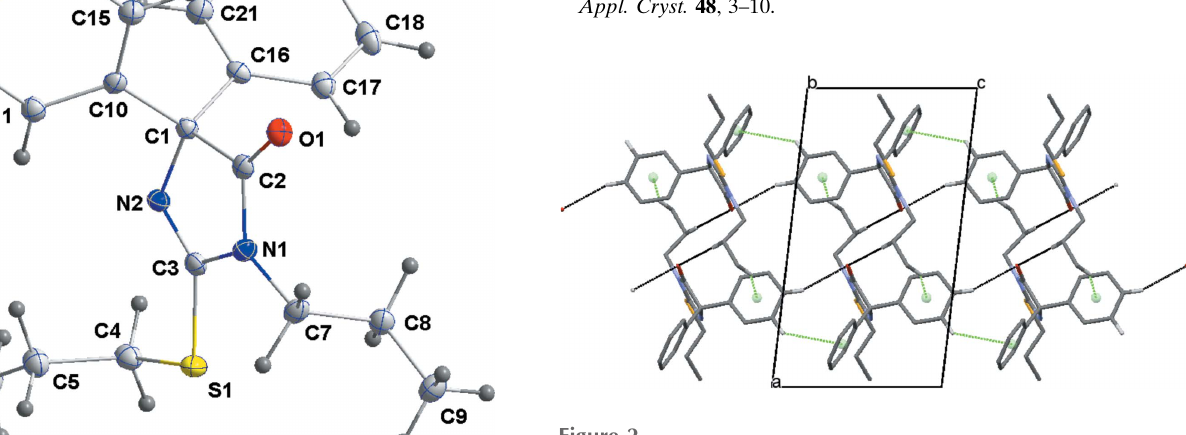
Figure 2 A portion of a chain of the title molecules viewed along the b -axis direction. C—H (cid:3)(cid:3)(cid:3) O hydrogen bonds and C—H (cid:3)(cid:3)(cid:3) (cid:2) (ring) interactions are shown by black and green dashed lines, respectively.